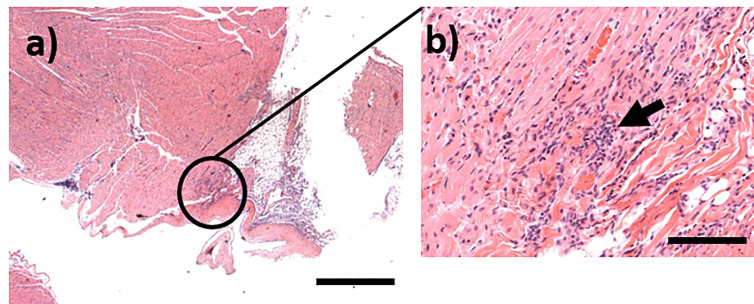
Representative H&E stained sections from marmosets challenged with C. burnetii.
 (A) Focal infiltration of the myocardium in an animal euthanasied at Day 14 post-challenge, bar =1mm; (B) High magnification image from (A) showing mixed inflammatory cells within the foci (arrow), bar =100μm.